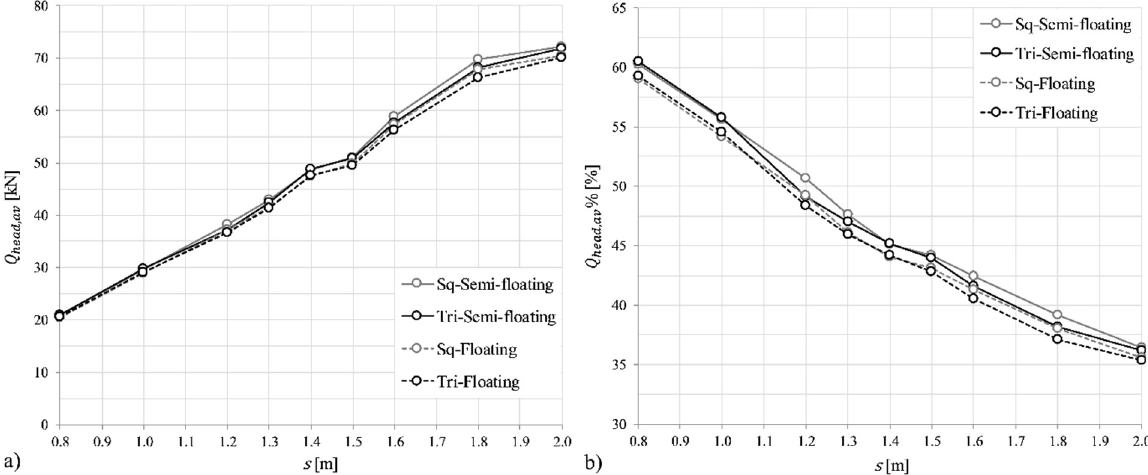
Figure 17. ( a ) The average pile head load ( Q head , av ) and ( b ) the average pile efficacy as percentage ( Q head , av %) with increasing s As seen in Figure 17b, 𝑄 (cid:3035)(cid:3032)(cid:3028)(cid:3031),(cid:3028)(cid:3049) % decreased approximately linearly over the range of 𝑠 for all pile groups by almost 25%, from about 60% at 𝑠 = 0.8 m to above 35% at 𝑠 = 2.0 m. When 𝑄 (cid:3035)(cid:3032)(cid:3028)(cid:3031),(cid:3028)(cid:3049) % = 100%, the sum of the embankment weight and traffic load is carried